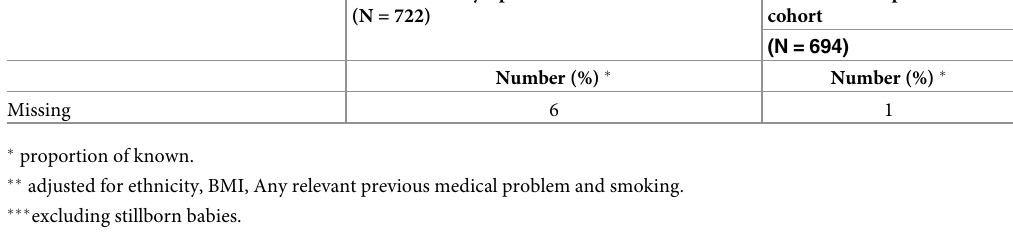
Of the 634 infants born to mothers with symptomatic SARS-CoV-2, 627 (99%) were